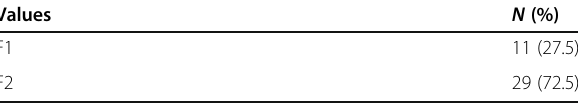
Table 2 PCR changes during treatment